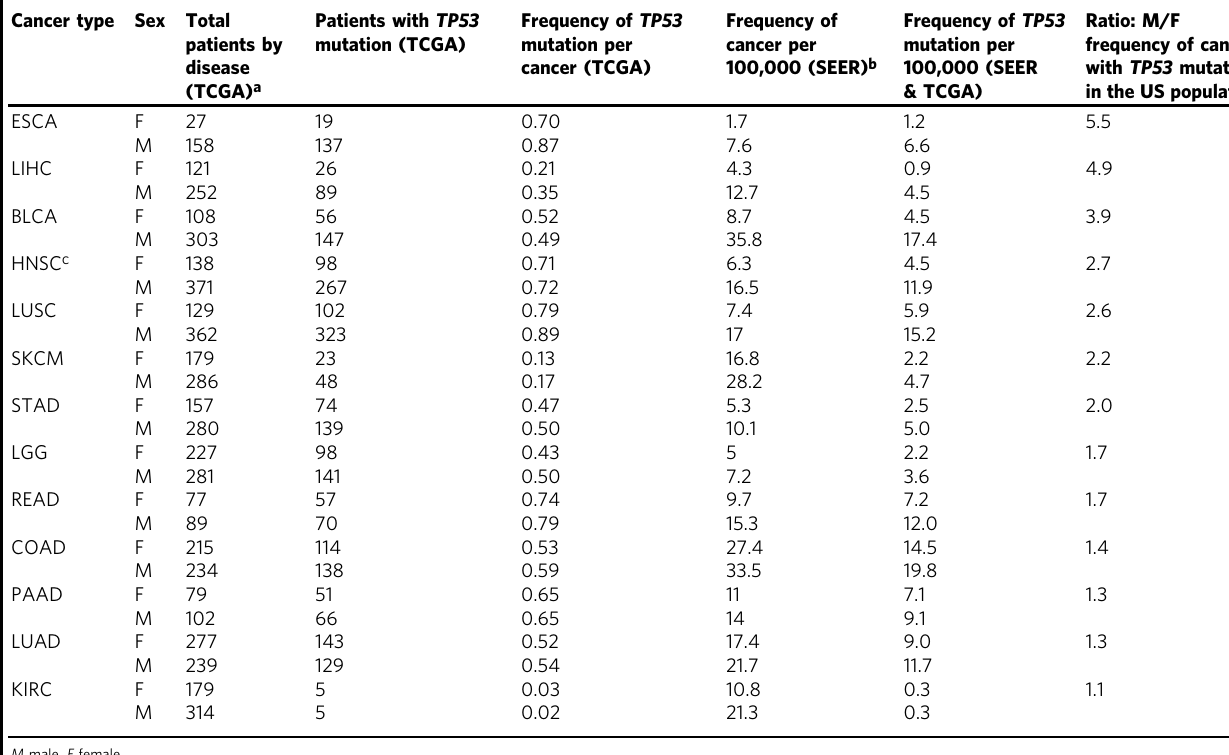
Table 1 Frequencies of cancers and TP53 mutation by